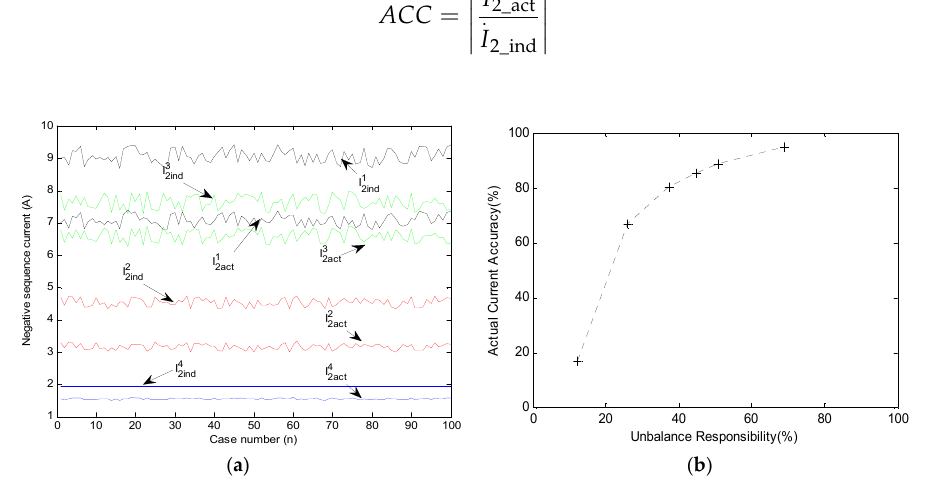
Figure 7. Sensitivity analysis results for the “individual current” and “actual current”: ( a ) comparison of the “individual current” and “actual current” for the four-feeder system; and ( b ) relationship between the actual current accuracy and unbalance responsibility.